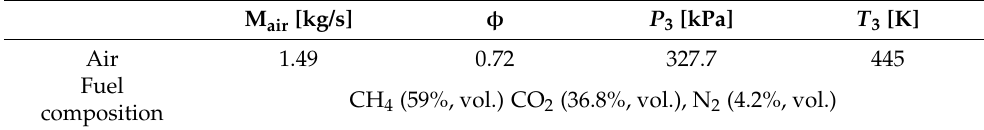
Figure 1. Schematic diagram and flow feature of the combustor.